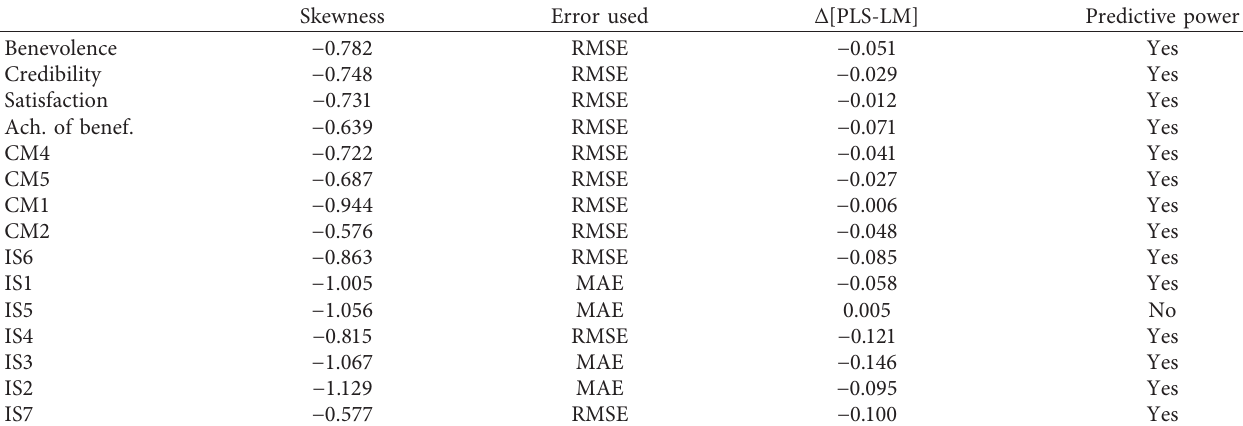
Table 15: Measurement of skewness of prediction